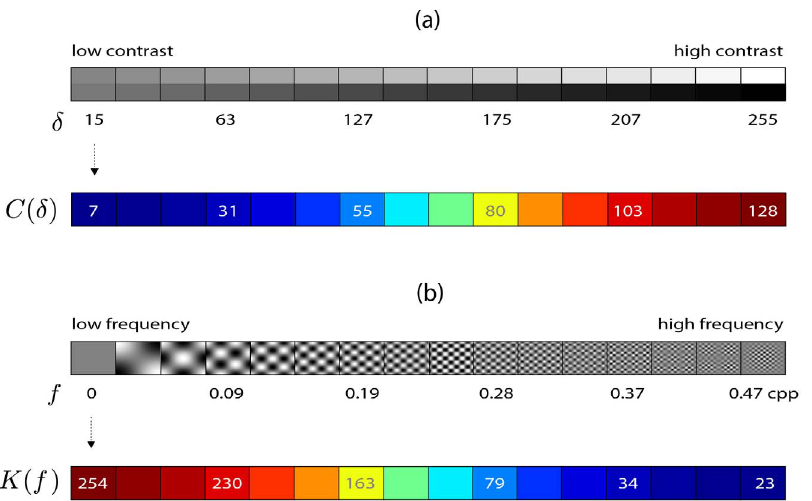
Figure 6. Representation of contrast and spatial frequency content by using RMS contrast and kurtosis. (a) The plot shows an array of image edges, each of 16 6 16 pixels. The number delta below each edge represents the luminance difference between upper and lower parts. From left to right, this luminance difference increases. The colored array of numbers C ( d ) are the RMS contrast values calculated when considering each edge an image neighborhood. (b) An array of two-dimensional cosine gratings of 16 6 16 pixels. The number f represents the spatial frequency of each grating. The colored array of numbers K ( f ) shows the respective kurtosis value generated by the proposed system.